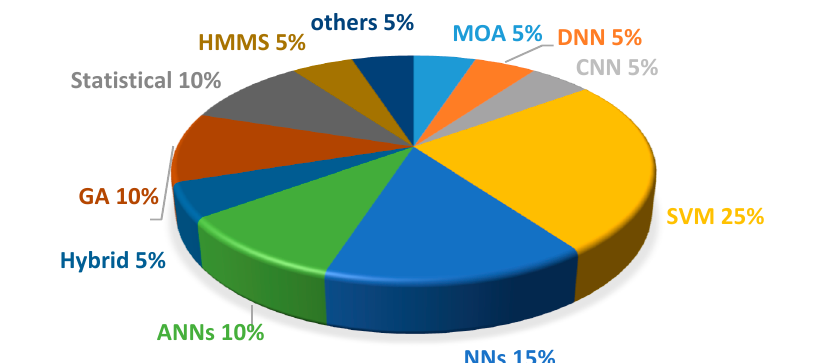
Figure 2. Computational techniques (percentage) used since 2001. MOA: Massive online analysis, DNN: Deep neural network, CNN: Convolutional neural network, SVM: Support vector machine, NNs: Neural networks, ANN: Artificial neural Networks, GA: Genetic algorithm, HMMs: Hidden Markov Model.